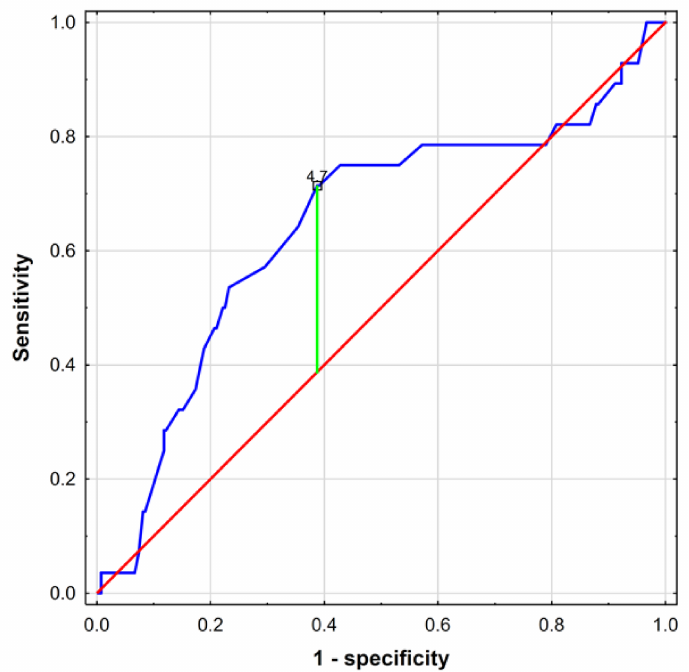
Figure 3. Receiver operating curve for interventricular septal thickness as a novel macrosomia predictor. A cut-off point of 4.7 mm is marked on the curve. Table 1. Statistical performance measures for interventricular septal thickness at ≥ 4.7 mm, large for gestational age/hypertrophy on ultrasound, and at least two of these parameters